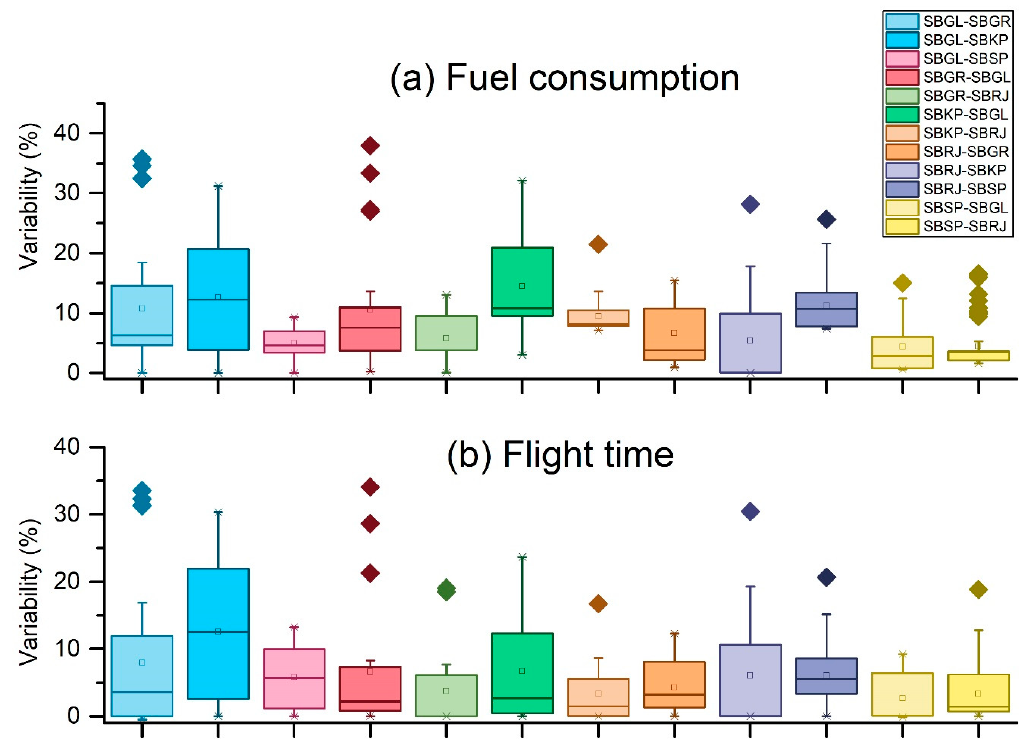
Figure 8. Gain variability for fuel consumption for each route due to air traffic interactions. ( a ) Fuel consumption; ( b ) Flight time.